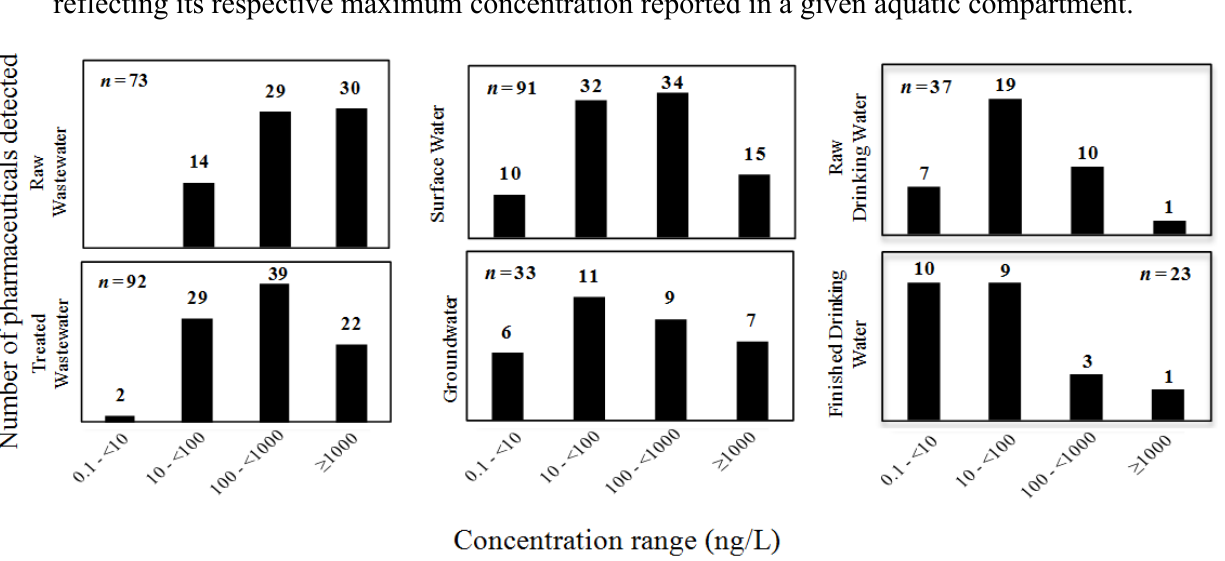
Figure 2. Number of pharmaceuticals detected in various water matrices of the built water environment. Each pharmaceutical is represented only once and shown in the category reflecting its respective maximum concentration reported in a given aquatic